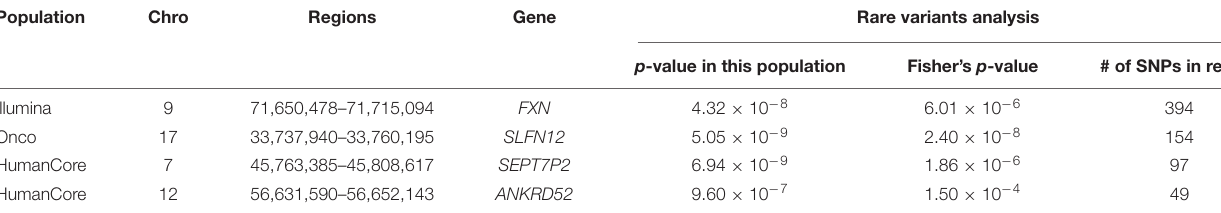
TABLE 6 | Regions identified by rare variants analysis in a particular population after Bonferroni